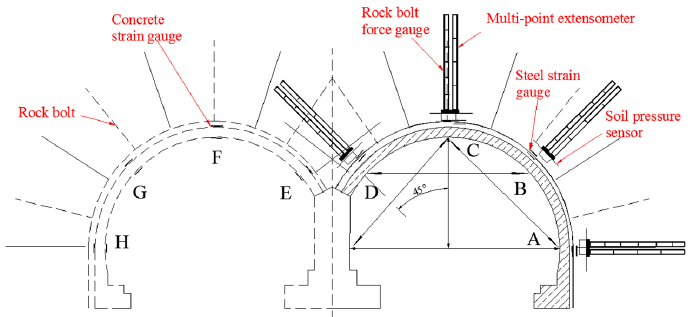
Figure 9. Layout diagram of the measuring points in class III surrounding rocks (K89+949).